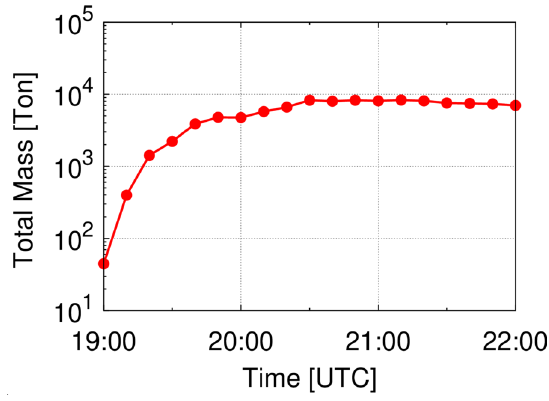
Fig. 5 Time series of the total mass in the ash clouds estimated